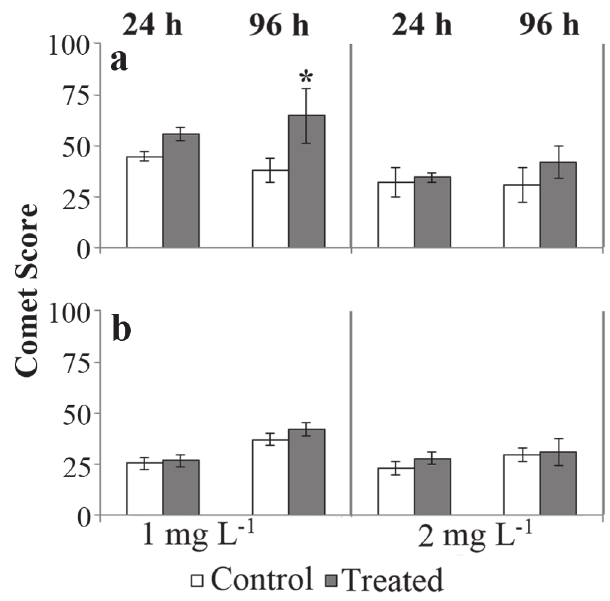
Fig. 5. Content of reduced glutathione (GSH) in gills ( a ) and liver ( b ) of Prochilodus lineatus exposed to 1 or 2 mg L -1 lyophilized Microcystis aeruginosa (treated) or only water (control), for 24 and 96 h. Values are presented as mean ± SEM (n = 8). Asterisks indicate significant differences when compared to respective control (p < 0.05).